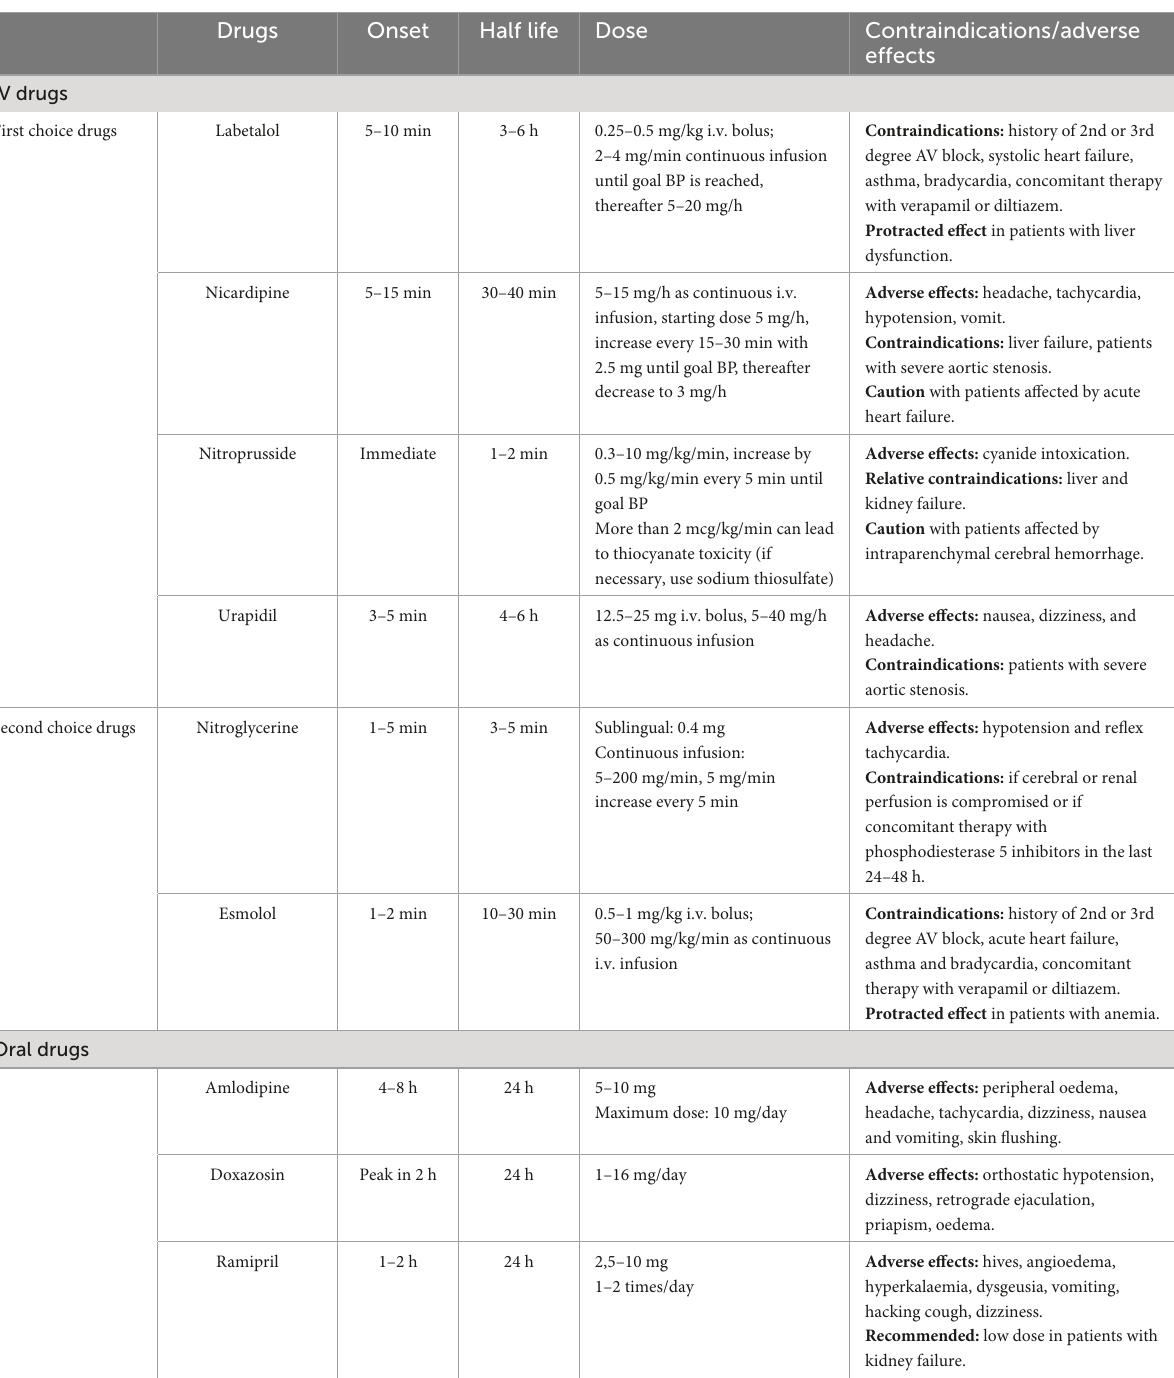
TABLE 1 Malignant hypertension